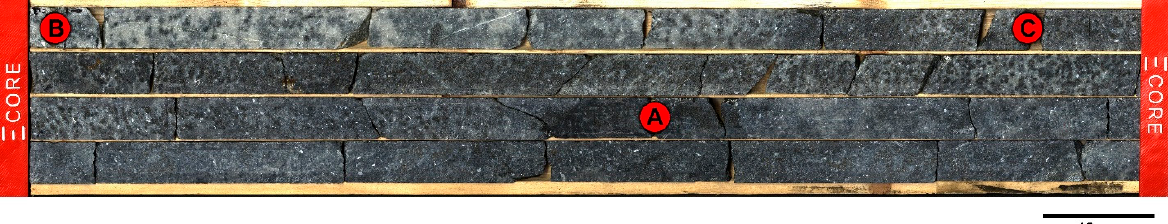
Figure 1. High-resolution image (57 µ m/pixel) of drill core tray (Stillwater Mine, USA) wherein the red circles correspond to the areas analyzed using a SEM-EDS analyzer (named Core A, Core B and Core C).